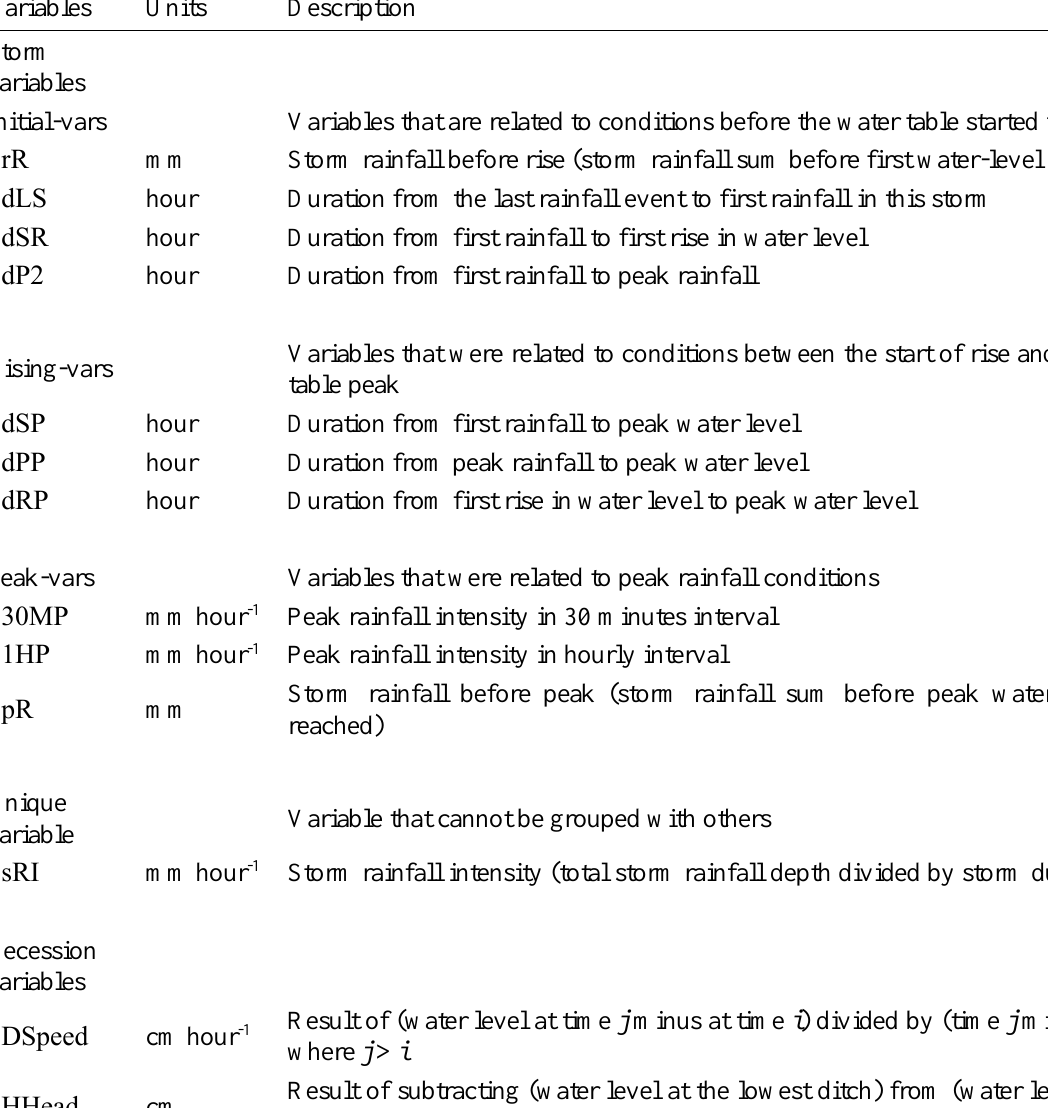
Table 1. Hydrological variables extracted from the storm